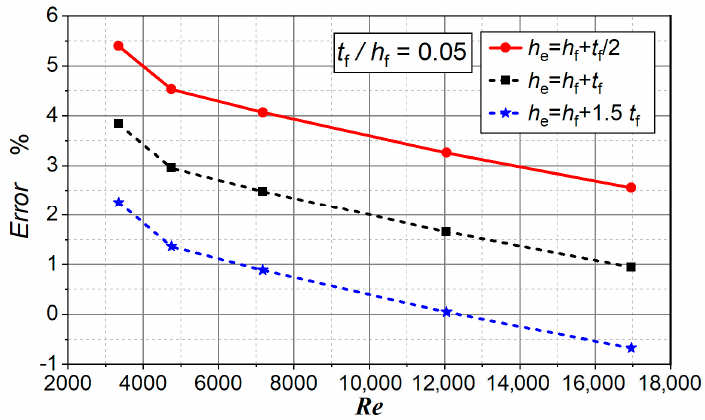
Figure 19. Error for adiabatic fin tip concept.